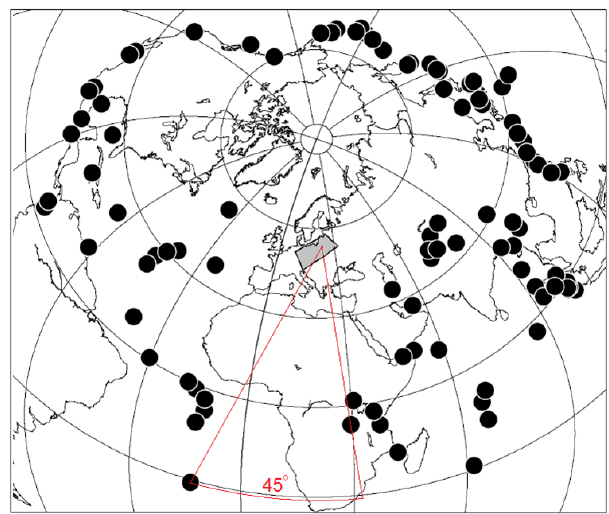
Figure 3. Map of epicenters of EQs (black circles) used in our study. Grey rectangle indicates the study area. Red lines show the largest seismic